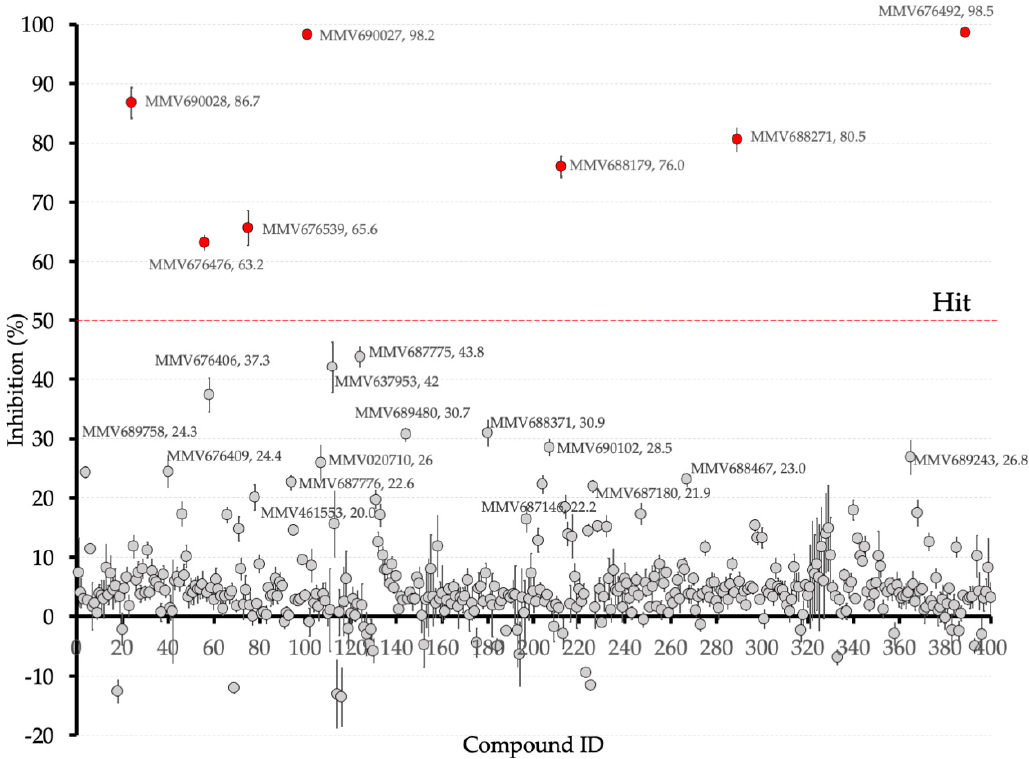
Figure 2. Overview of all the compounds from the Pathogen Box and their inhibition percentages against recombinant PfMQO at 10 μ M.